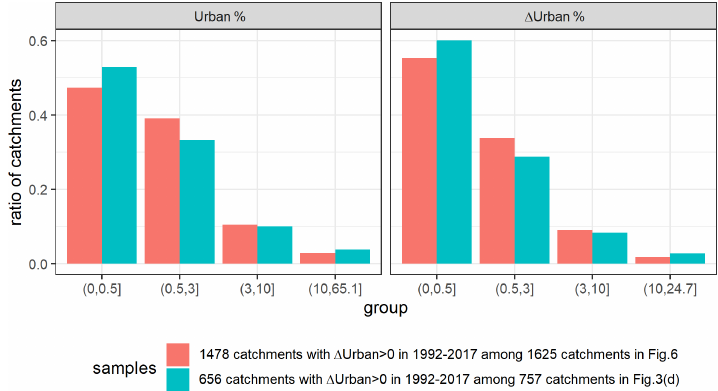
Figure A2. Frequency distribution of Urban and (cid:49) Urban in catchments with (cid:49) Urban > 0 from two catchment sets: the one used for the regression in Fig. 3d (green) and the one used for the flood change attribution in Fig. 6 (red).